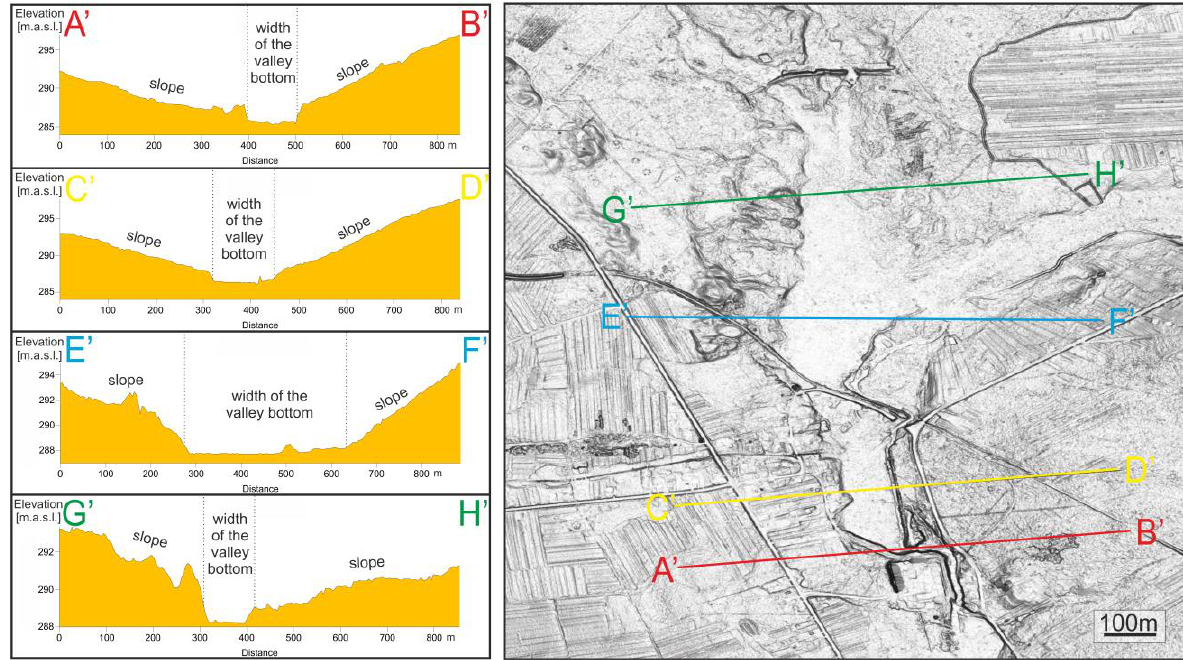
Fig. 9. Location of the former Furmanów ironworks on the shaded relief map with cross section lines representing valley